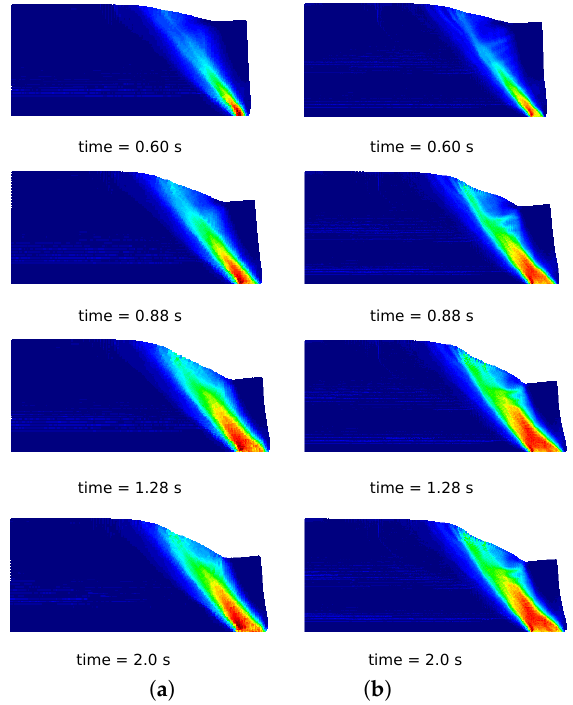
Figure 11. Soil column collapse. Distribution of equivalent plastic strains for different representative time instants in the MPM results. ( a ) Mesh 1; ( b ) Mesh